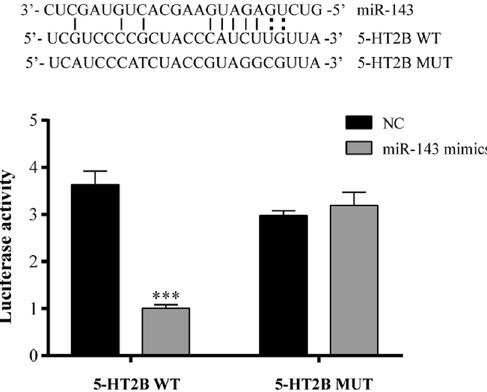
Figure 5. Relative luciferase activity for different groups co-transfected with an miR-143 mimic (5-HT2B-WT or 5-HT2B-MUT vectors). The asterisks above the horizontal line indicate significant differences between 5-HT2B-WT + miR-143 mimic and 5-HT2B-WT + NC mimic groups ( P < 0.05).